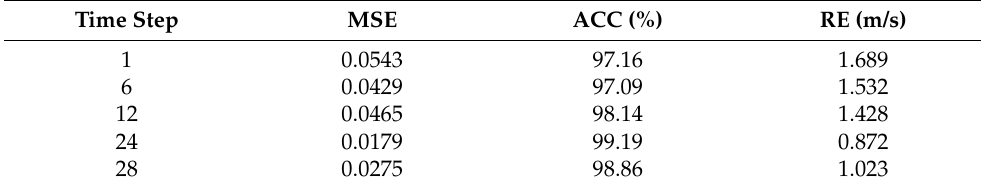
Table 1. Predicted results of different time steps at (24.5° N, 169.5°